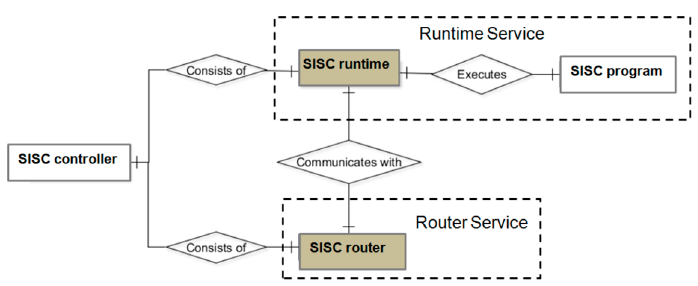
Figure 7. SICS services architecture according Figure 4 presented as an entity relationship diagram (ERD) diagram.